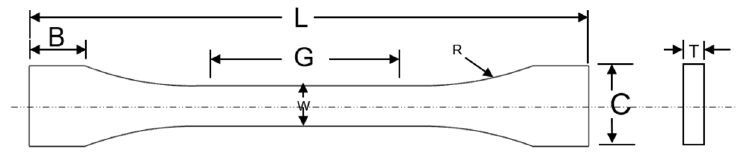
Figure 3. Schematic diagram of SLM 316L stainless-steel metal specimen. Table 1. Parameters of 316L stainless-steel